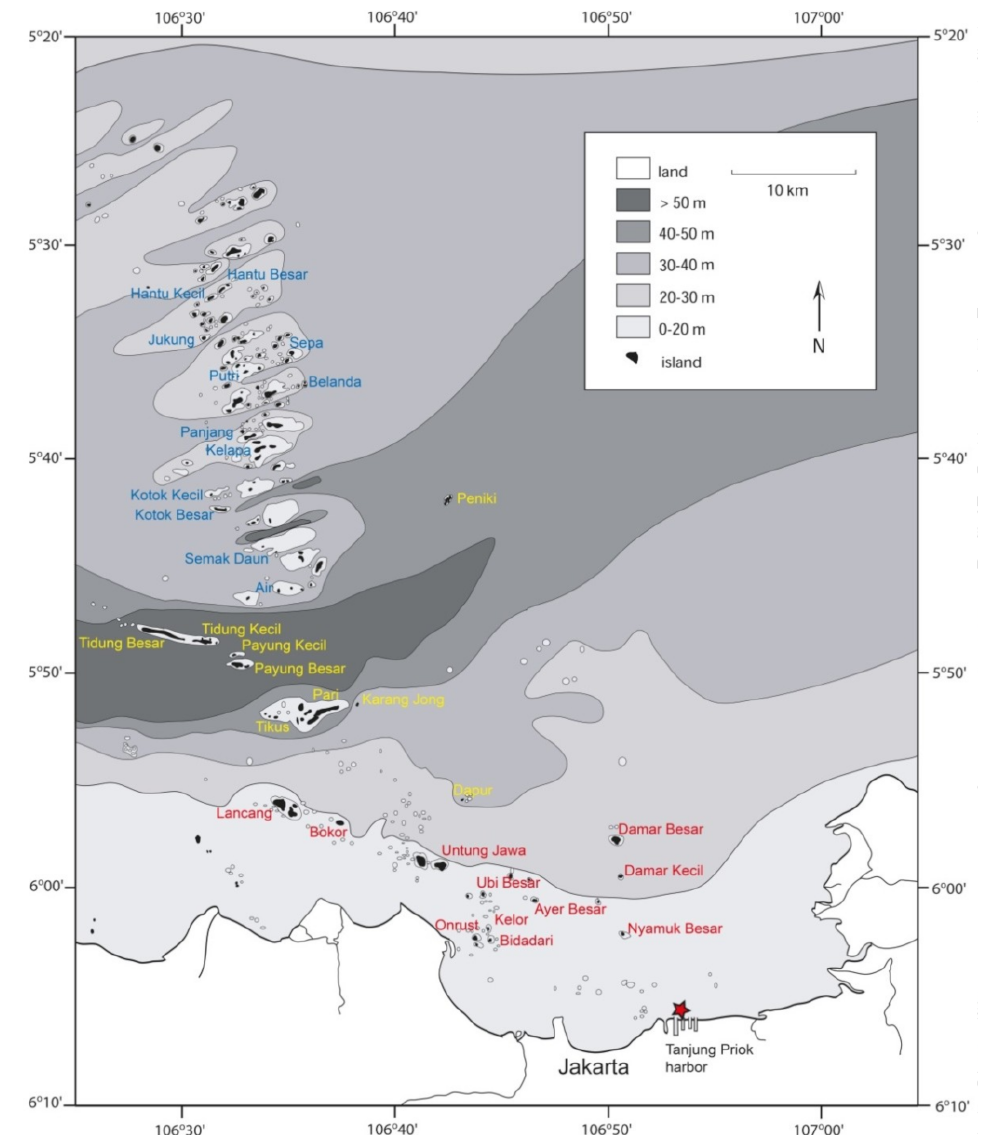
Figure 1. Map of Jakarta Bay and the Thousand Islands archipelago (Kepulauan Seribu) off Jakarta. Reefs surveyed in 2005 (Table 1) are indicated by their name in different colors to distinguish three shelf zones that vary in distance offshore and depth range: Red = Zone 1 (0–30 m), yellow = Zone 2 (30–60 m), blue = Zone 3 (20–40 m). The reference point for Tanjung Priok harbor is